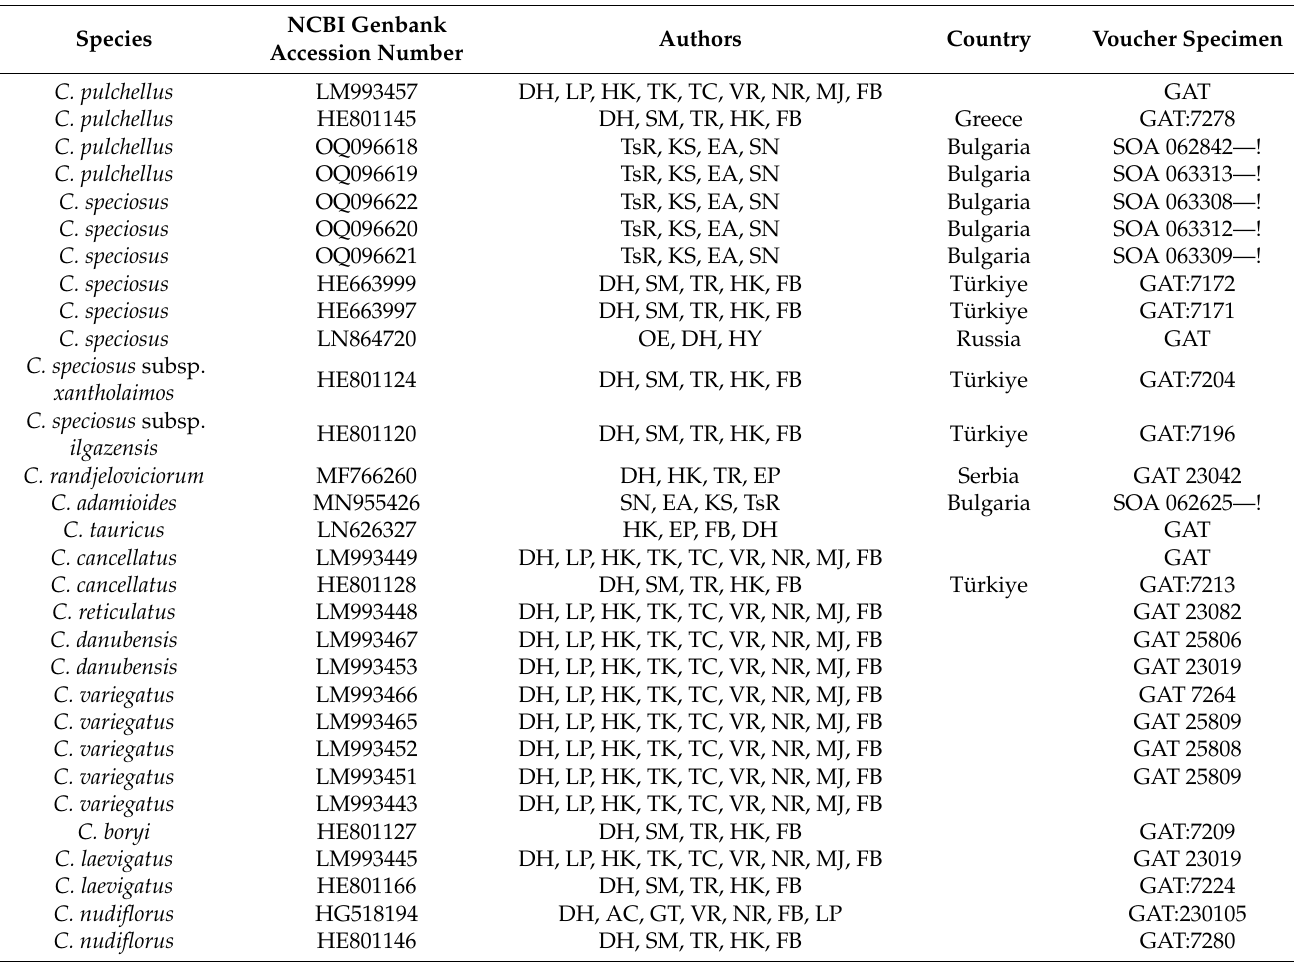
Table A2. Data for the ITS sequences from the NCBI GenBank database used for the phylogenetic analysis (Figure 6. Author names are abbreviated as follows: AC—A. Carta, DH—D. Harpke,